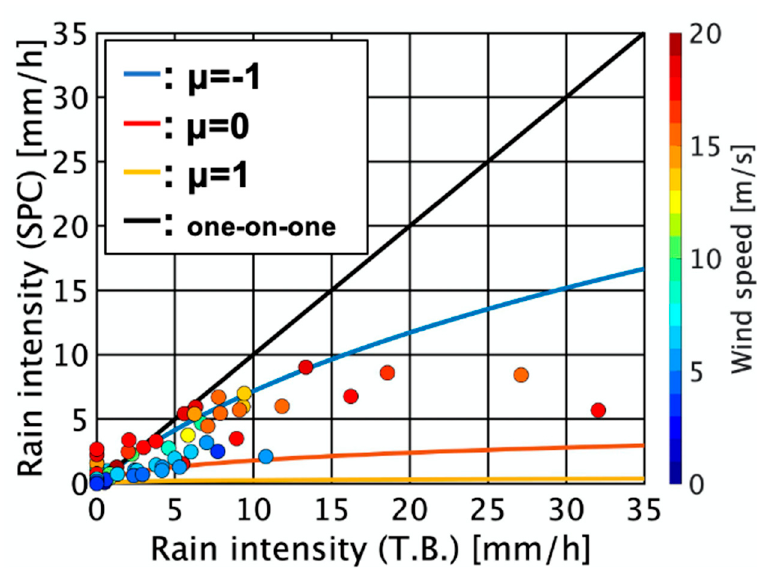
Figure 5. Relationship between rainfall intensity (R ctb ) and the intensity derived from SPC data (R SPC ). Hourly wind speed is indicated in bar colors. Lines indicate the relationship between rainfall intensity of drops with diameters less than 1 mm and total rainfall intensity based on Ulbrich distributions for different values of μ , where light blue = − 1, red = 0, and orange = 1. Black line indicates a one-on-one line.